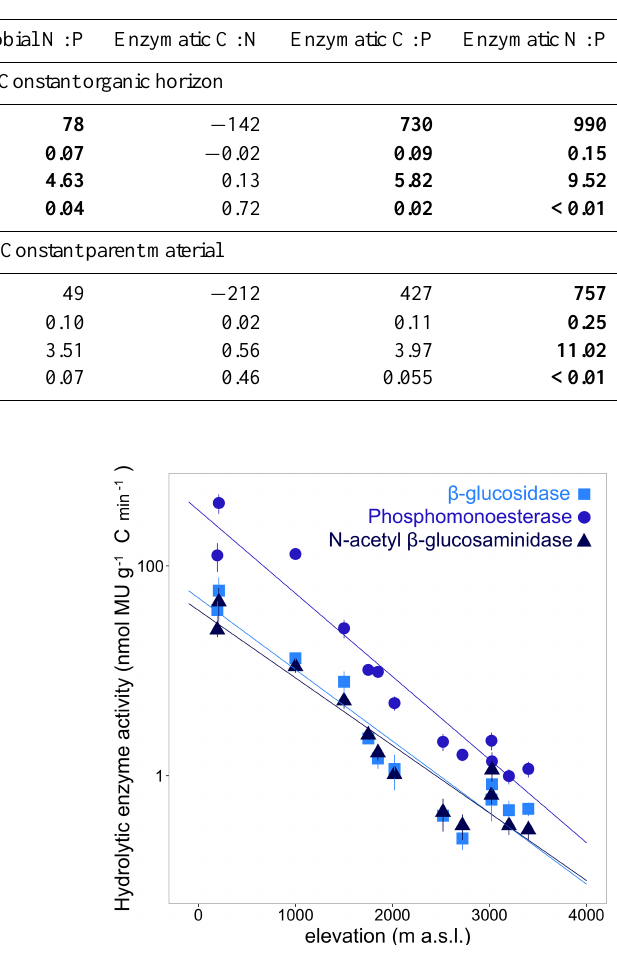
Figure 4. Enzyme activities of C ( β -glucosidase) N ( N -acetyl β - glucosaminidase) and P (phosphomonoesterase) – degrading en- zymes for 13 sites at elevations ranging from 194 to 3400m, de- termined at the mean annual temperature (MAT) for each site (Ta- ble 1). Enzyme activity at MAT was determined using linear regres- sion of temperature and enzyme activities determined at 2, 10, 22 and 30 ◦ C (Table S1). Linear regressions are shown, where p <0.05. Values are means ± 1 SE ( n = 5 replicates, which represents the spa- tial variation within a 1ha